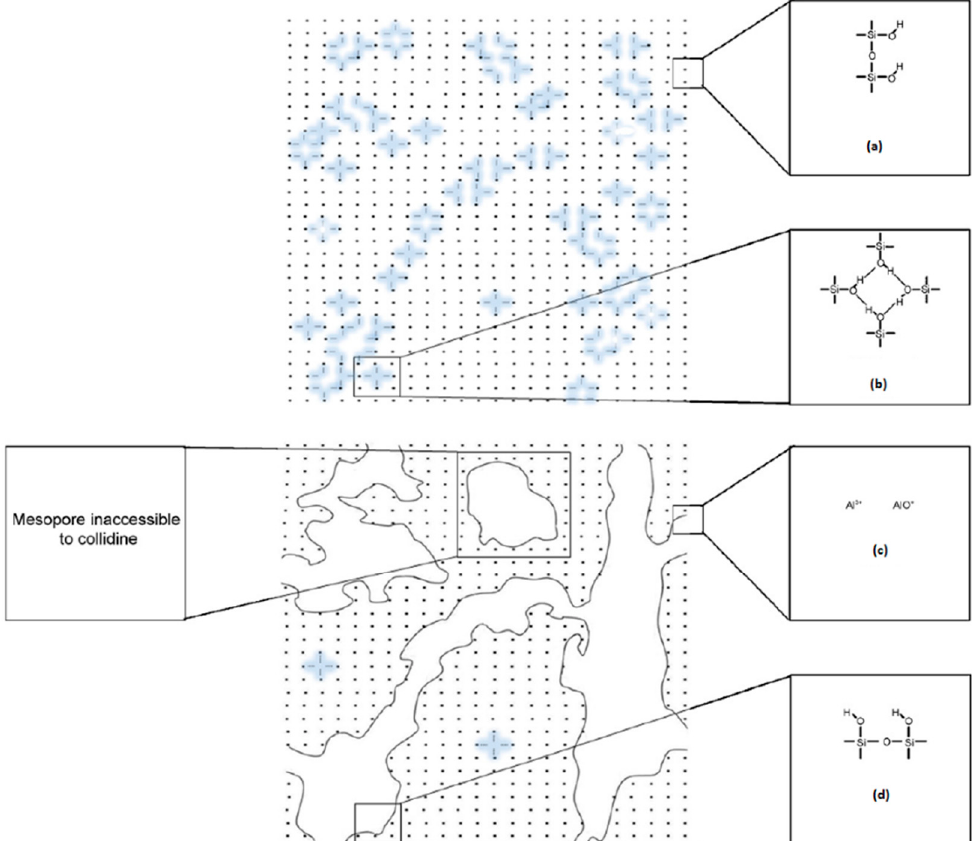
Figure 3. Schematic illustration of the mesopores incorporation to conventional zeolites upon alkaline desilication (Adapted from [84]. Copyright 2009 Elsevier).